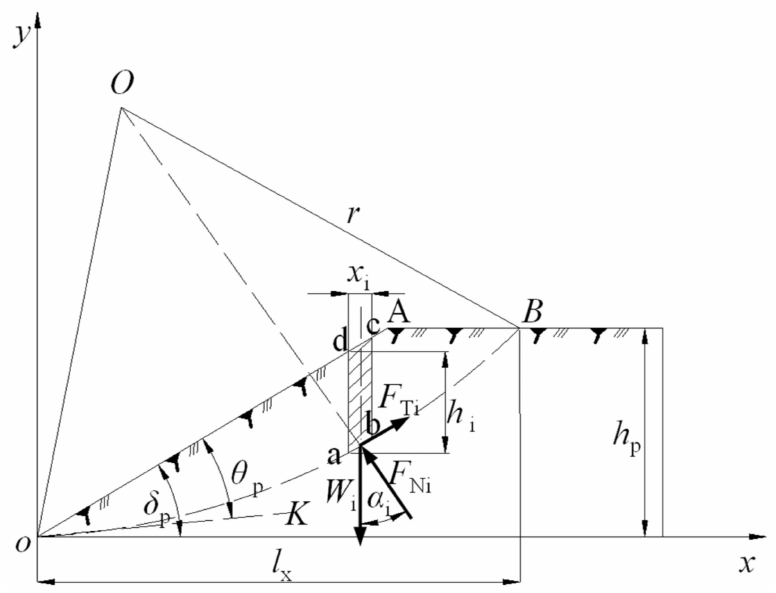
Figure 5. Mechanical model of slope body in loess